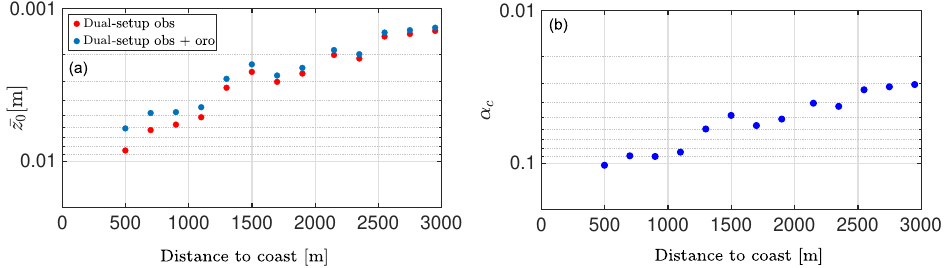
Figure 9. Mean estimated roughness length dependency with distance to the coast for the dual-set-up mean wind profiles after and before applying orography corrections (a) . Charnock’s parameter dependency with the distance to the coast (b) .